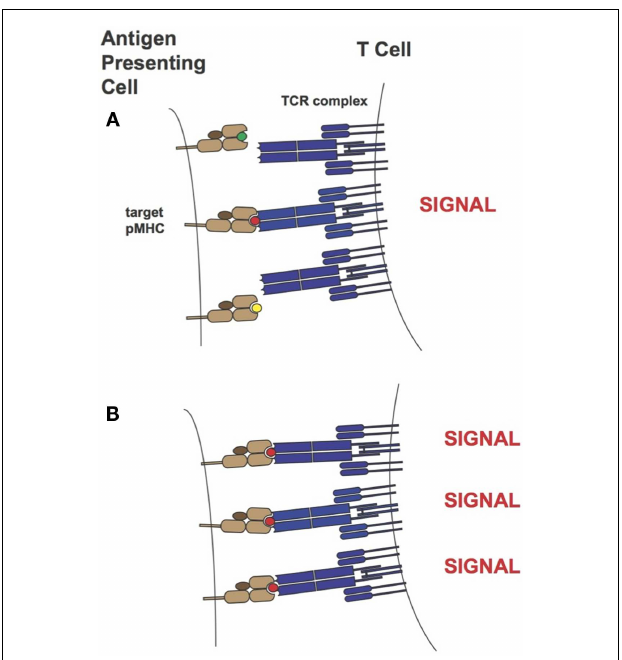
FIGURE 13 |T-cell activation in the presence of limiting (A) or saturating levels (B) of target pMHC complex. In the case where target pMHC concentration is limiting,TCRs of too high-affinity may inhibit serial engagement and thereby attenuateT-cell activity levels. MHCs are colored in light brown, β 2-microglobulins in dark brown,TCRs in blue and peptide antigens are shown as small green, red, and yellow circles.The peptide colored in red corresponds to the specific